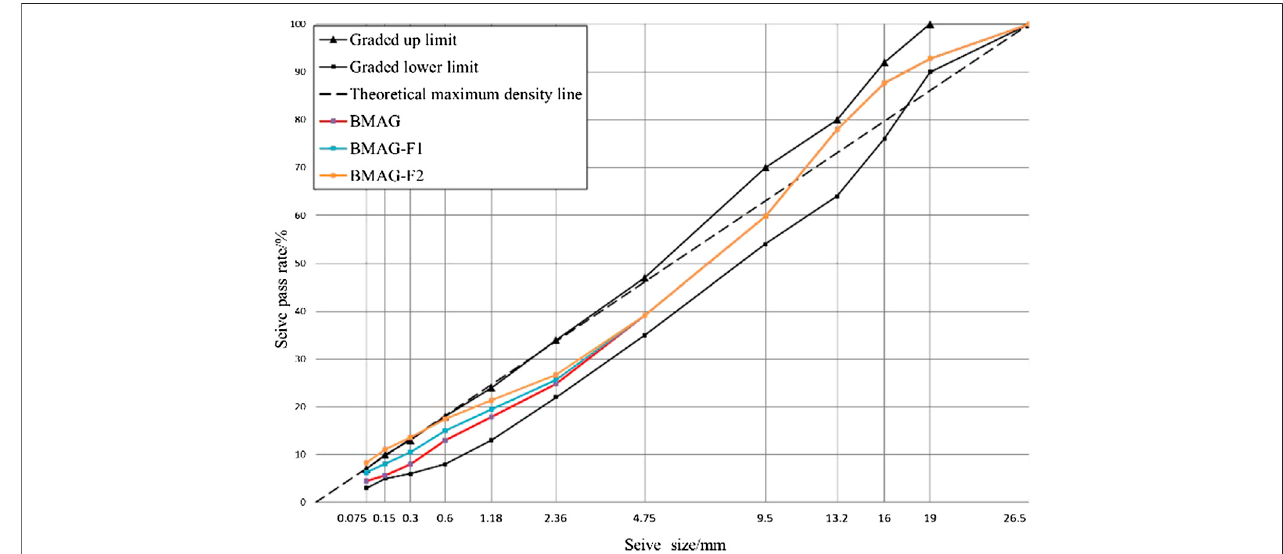
FIGURE 4 | Gradation curves of fi ne material variability.